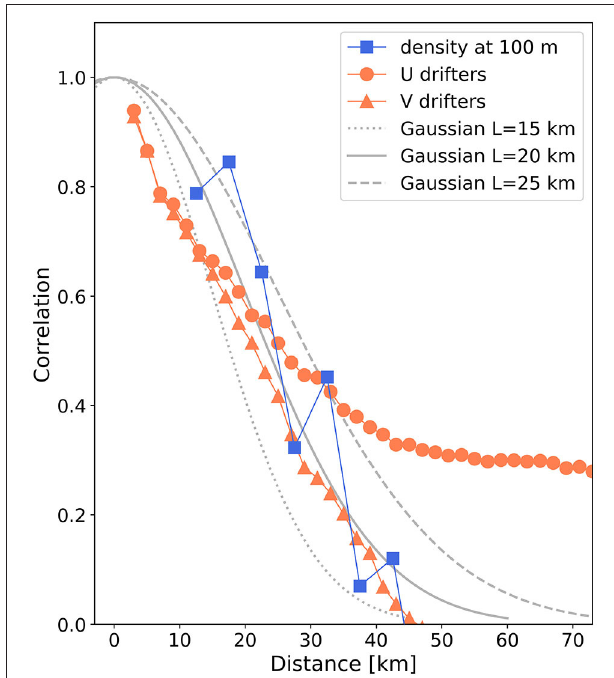
FIGURE 10 | Correlation between data pairs that are separated by a defined distance (x-axis) and considering a bin size of 5 km for the original density from Leg 1 at 100 m depth (blue squares), and considering a bin size of 2 km for the zonal and meridional components of the drifter velocity (orange dots and triangles, respectively). As an example, the first square is the correlation of those density data pairs that have a separation between 10 and 15 km. Gray dotted, solid, and dashed lines represent three Gaussian functions with standard deviations of 15, 20, and 25 km, respectively. The Gaussian function that resembles better the empirical correlations is likely the Gaussian with a standard deviation of 20 km, and this is the correlation scale used to interpolate the original fields from Leg